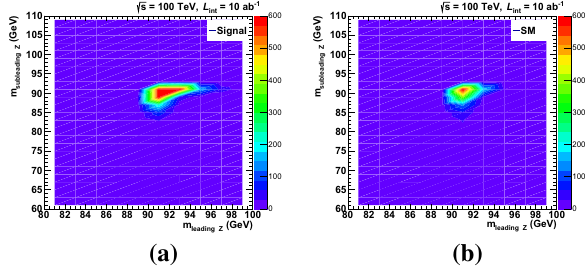
Fig. 7 Invariantmassdistributionsofsub-leading Z bosonversuslead- ing Z boson for signal (left) and main background (right) for the 2 e 2 μ decay channel. The z-axis corresponds to the number of events where the red color represents the highest number of events